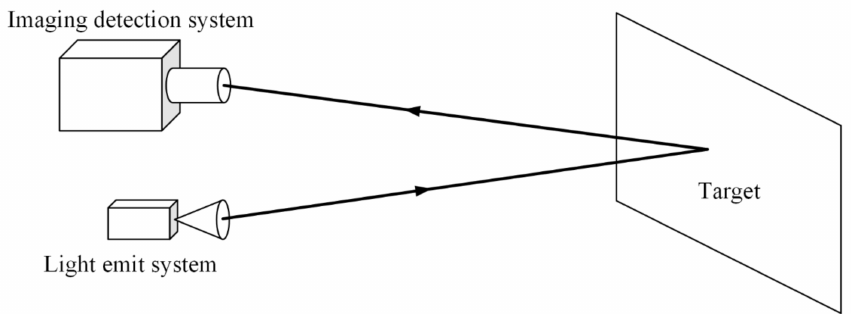
Figure 8. Schematic diagram of the experimental system.